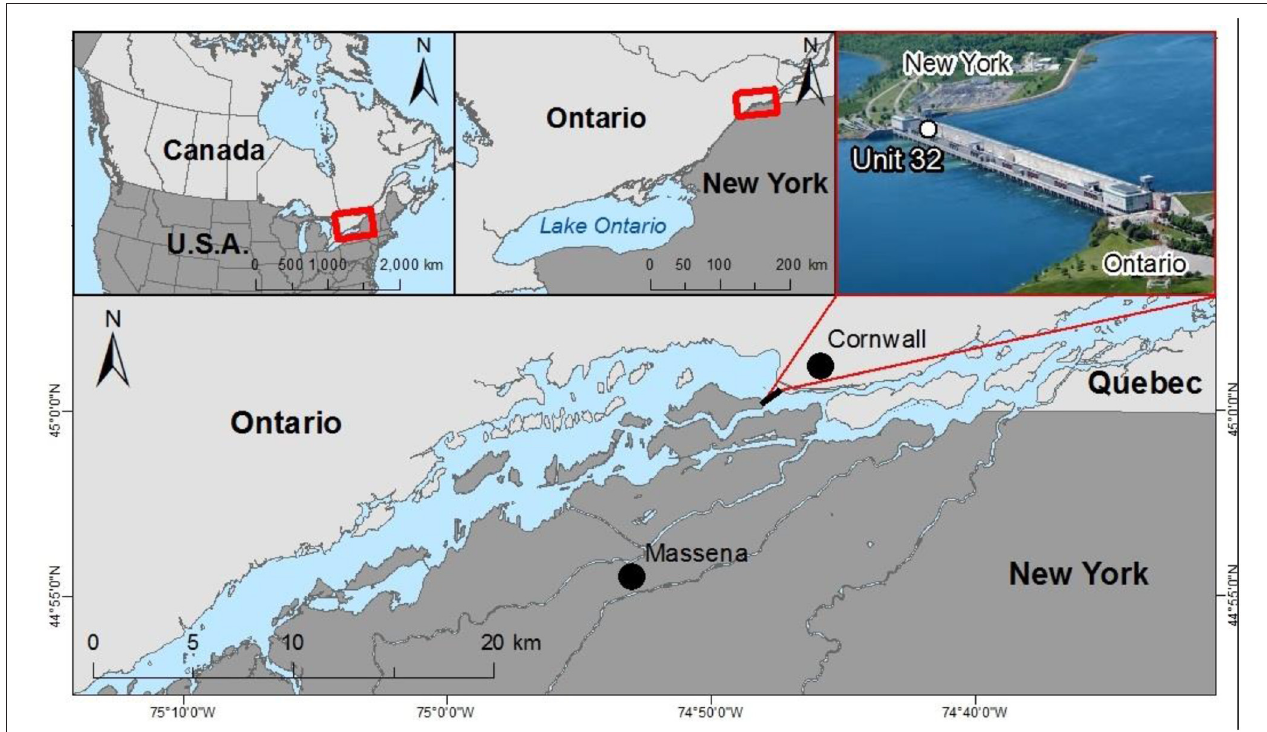
FIGURE 1 | Geographical location of the Unit 32 power turbine of the Moses-Saunders hydroelectric dam on the Upper St. Lawrence